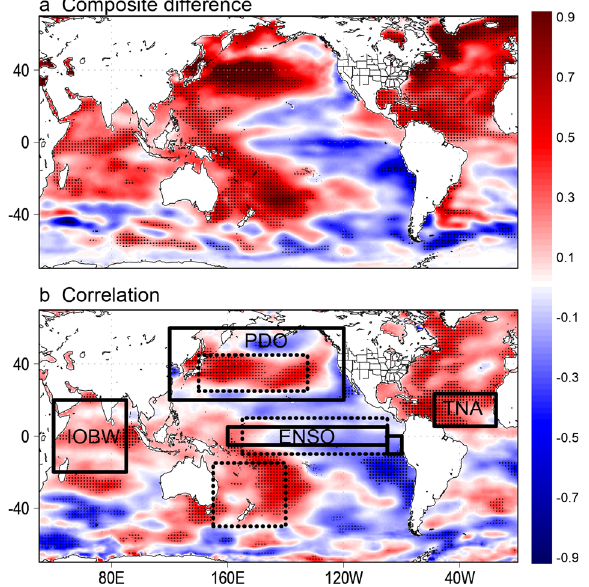
Fig. 6 Relationship of sea surface temperature (SST) and tropical cyclone (TC) passage frequency in East Asia during the mature boreal autumn. a Global composite difference map of SST between Period 2 (1998 − 2019) and Period 1 (1981 − 1997), respectively. b Spatial correlation map of TC passage frequency and SST. The black solid (dotted) boxes indicate the locations of indicated climate index (Interdecadal Paci fi c Oscillation regions). In a , b , the black dots indicate signi fi cant difference and correlation at p < 0.05, respec- tively. Signi fi cance is tested using student ’ s t-test statistic with two- tailed